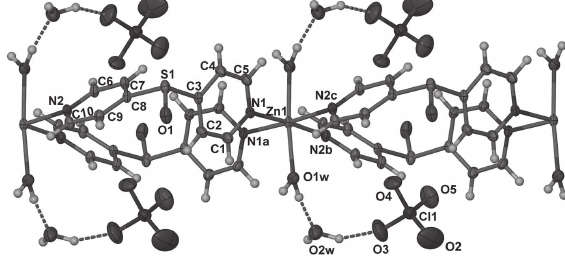
Table 1: Data collection and handling.